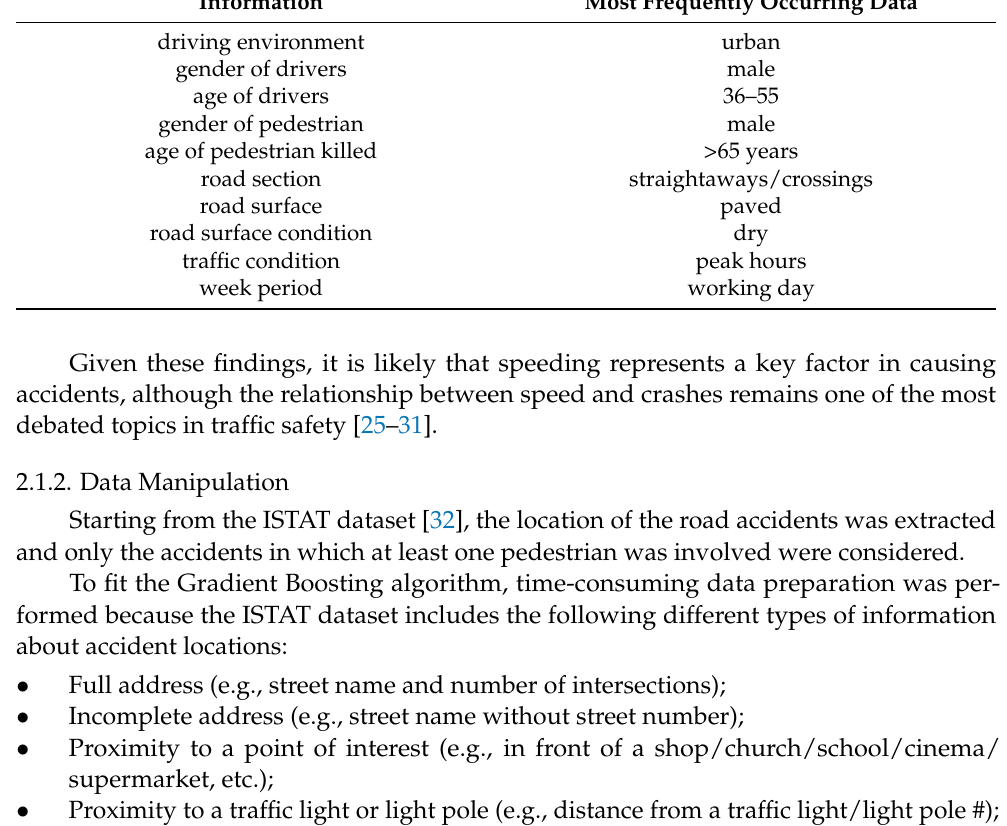
Table 2. List of most frequently occurring data. Information Most Frequently Occurring Data driving environment